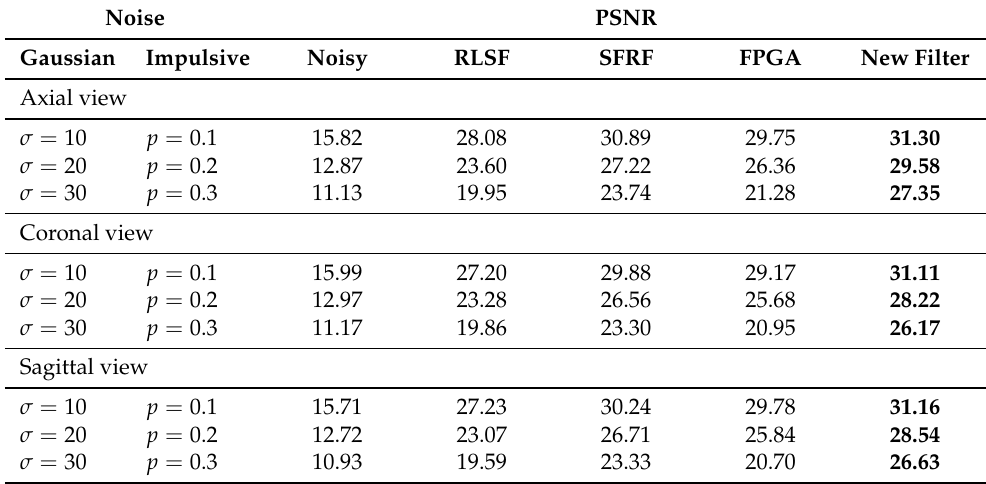
Table 2. PSNR measure for noisy and denoised CT images. Values in bold denote the best filtering quality. Noise